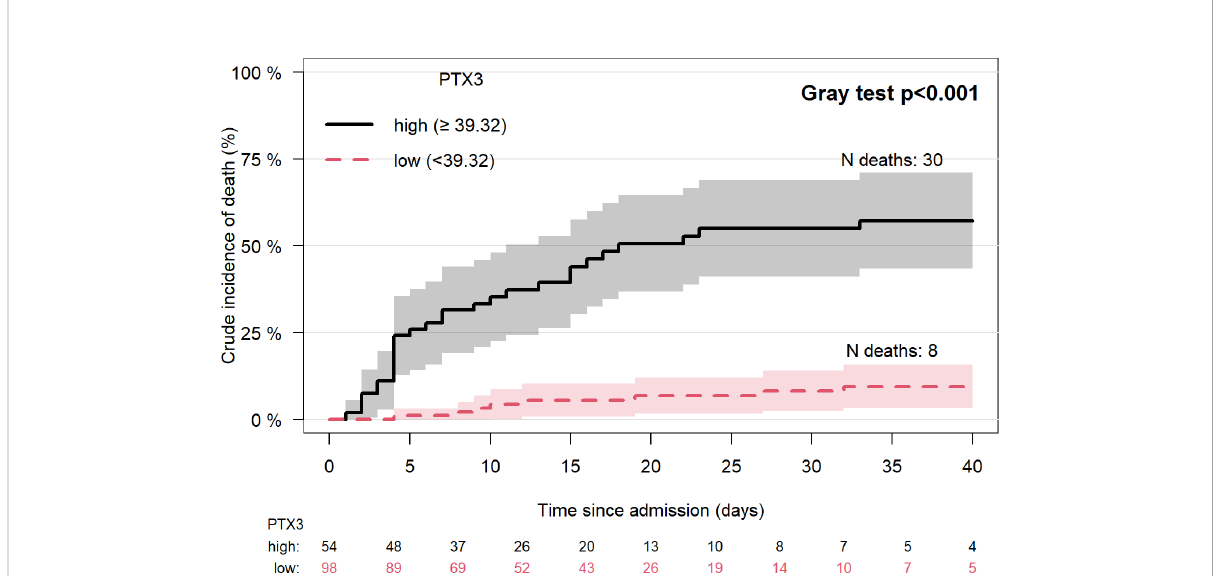
FIGURE 2 Crude incidence of death (discharge as competing risk) by PTX3 high or low (best cut-off based on Maximally Selected Rank Statistics method). List of abbreviations: N, number; PTX3, pentraxin 3. Lines represent the cumulative crude incidence of the outcome and the shaded areas its 95% con fi dence interval. The numbers below the plot indicate patients at risk in time in the two